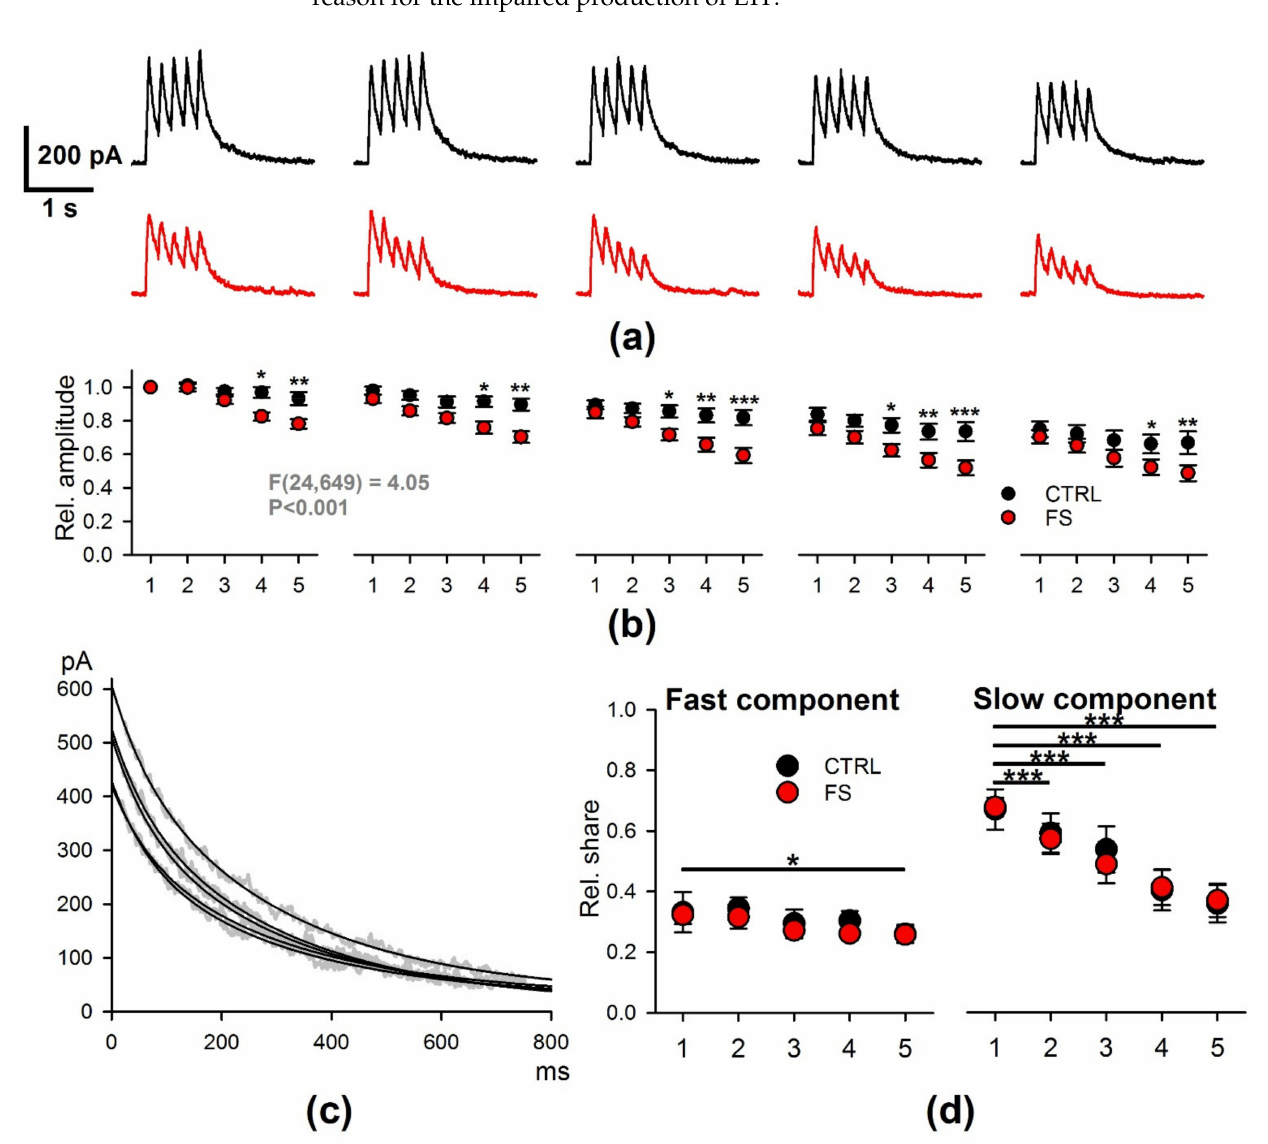
Figure 8. The properties of NMDAR-mediated currents evoked by TBS were disturbed in FS rats. ( a ) The representative voltage-clamp recordings of NMDAR-mediated currents, induced by TBS in CA1 neurons in control (black) and FS rats (red). ( b ) The average amplitudes of the individual peaks of current within the responses, normalized to the amplitude of the first response. Mixed-model ANOVA revealed a significant interaction between the factors (FS × stimulus number). Asterisks indicate the significant difference between the values of control and FS rats for the same stimulus number according to Dunnett’s post hoc test. ( c ) The representative recordings of the 90–10% decays of NDMAR-mediated currents evoked during the TBS. The currents were fitted with the biexponential function with the time constants of τ fast = 65 ms and τ slow = 300 ms. ( d ) The relative contribution of the fast and slow components of the response during the TBS. Mixed-model ANOVA did not reveal a difference between the control and FS rats. Asterisks indicate the significant difference with the first response. * p < 0.05; ** p < 0.01; *** p <